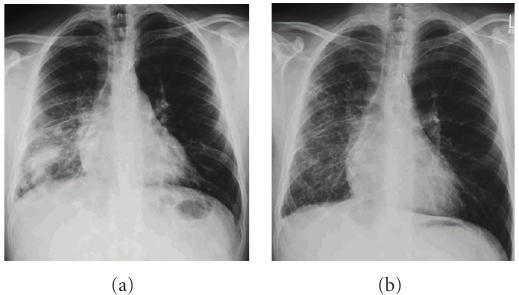
Figure 1: Chest radiographs (a) at presentation in GUCH clinic and (b) after several weeks of antibiotic treatment. Right pulmonary venous obstruction is suggested by the presence of dilated venules, Kerley lines and fluid in the fissures, all more obvious after the consolidation was treated.